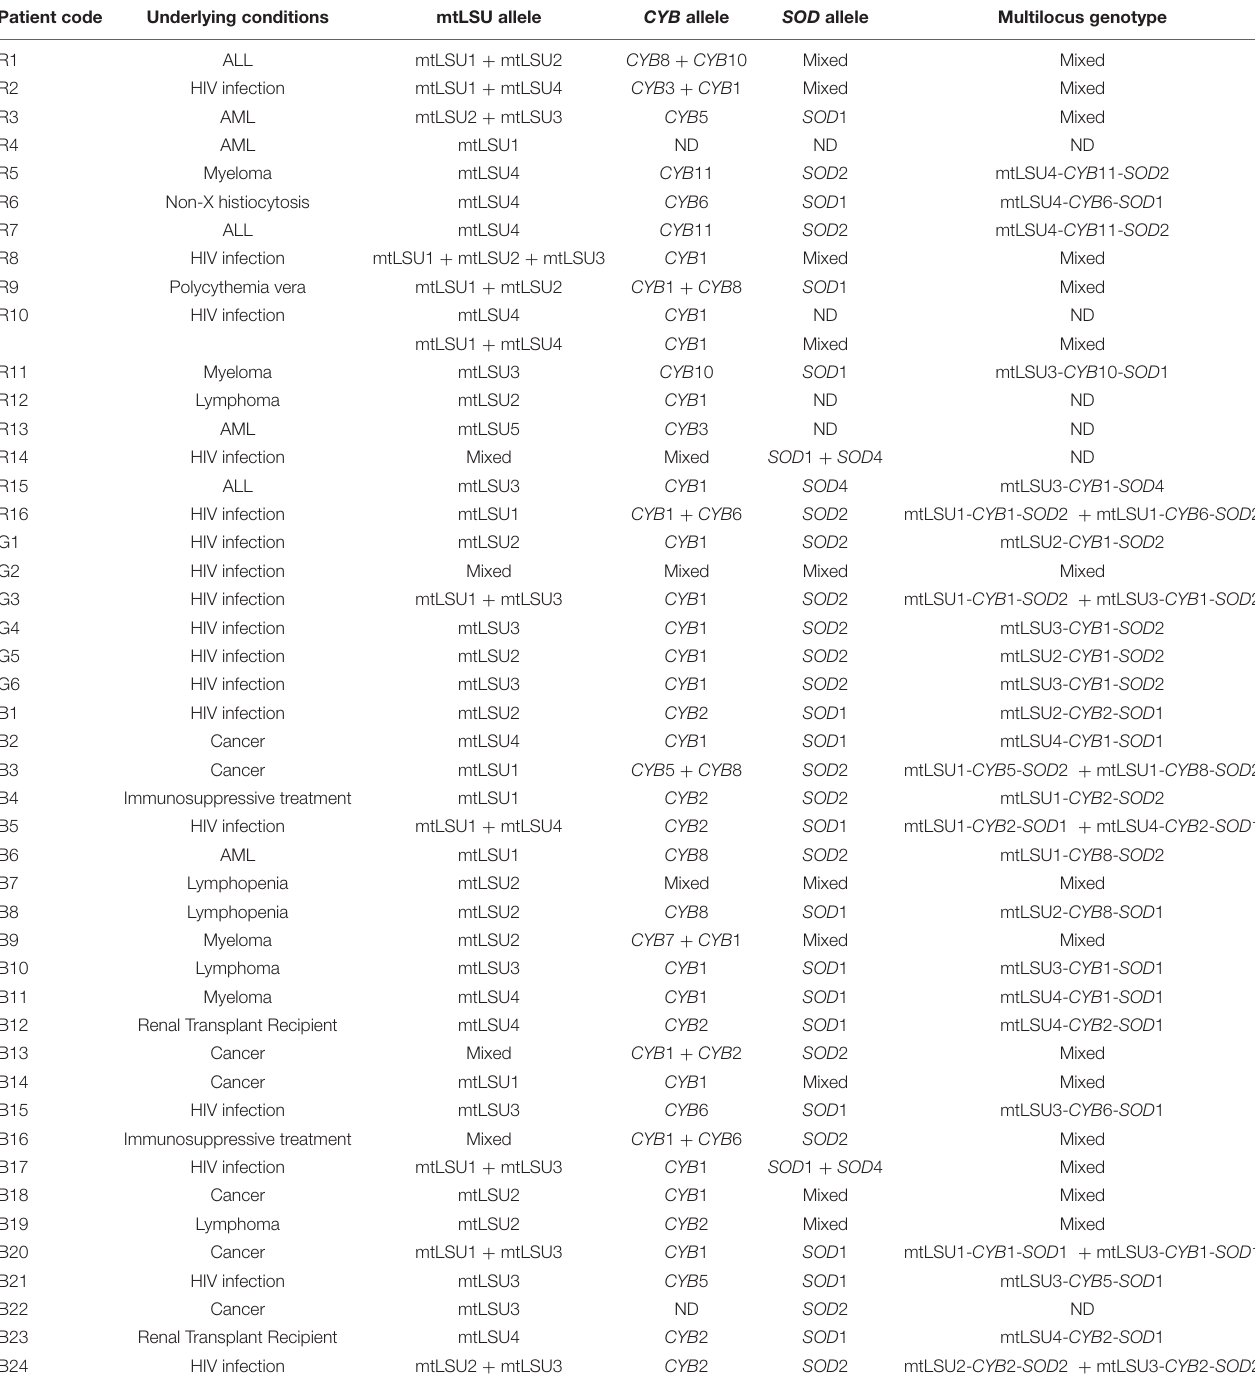
TABLE 2 | Genotypes of Pneumocystis jirovecii identified in patients developing Pneumocystis pneumonia from Réunion, French Guiana and Brest. Patient code Underlying